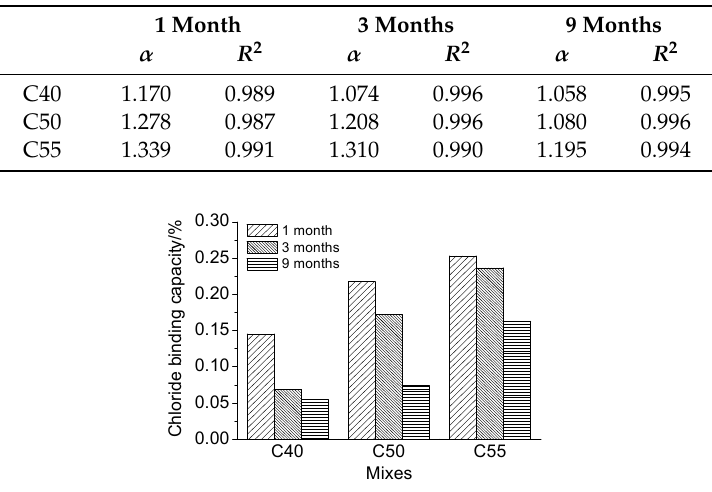
Figure 14. Chloride binding capacity of C40, C50, and C55 exposed to the tidal zone after different times.